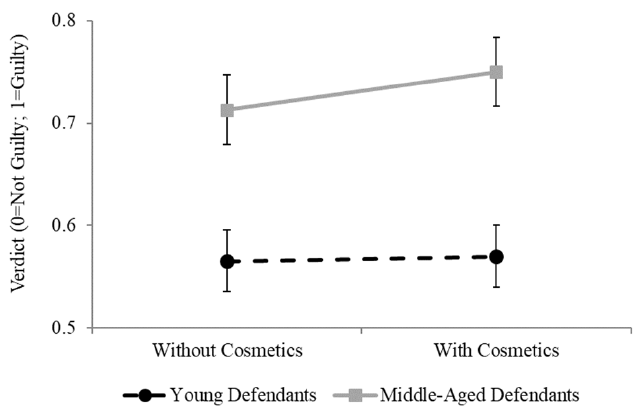
Figure 1. Verdicts given to young defendants (dashed line, filled circles) compared to verdicts given to middle-aged defendants (solid line, filled squares) by both male and female participants. Standard error bars are displayed.